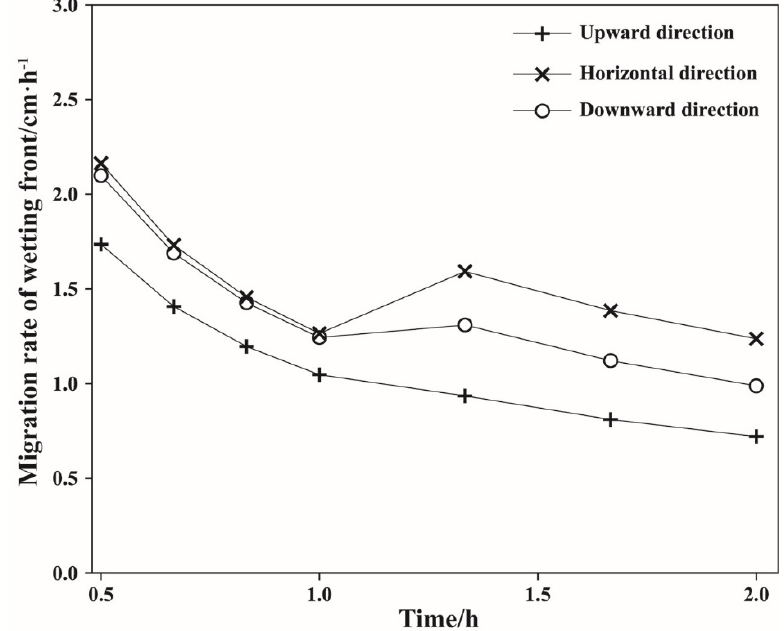
Figure 9. Migration of wetting front in layered soil.